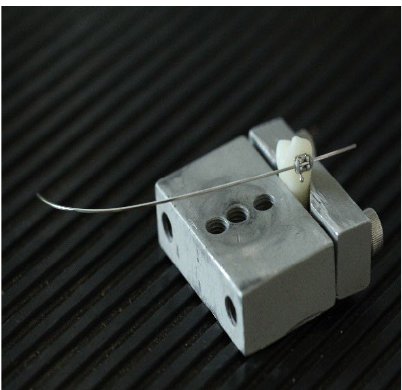
Figure 4. Locked premolar conventional bracket with elastomeric ligature.